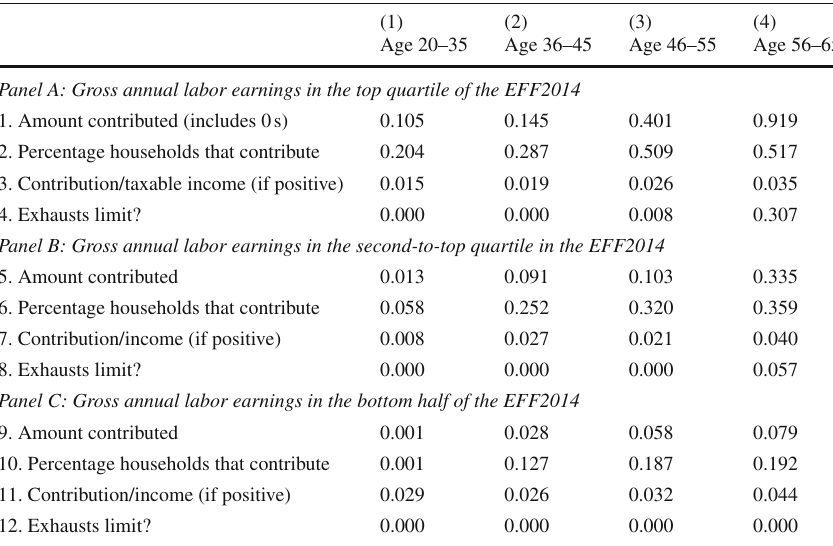
Table 8 Household contributions to pension funds by age and income group, Encuesta Financiera de las Familias 2014. Source : Encuesta Financiera de las Familias 2014, sample of households whose reference person is an employee. Monetary magnitudes in 1000 euros of 1987